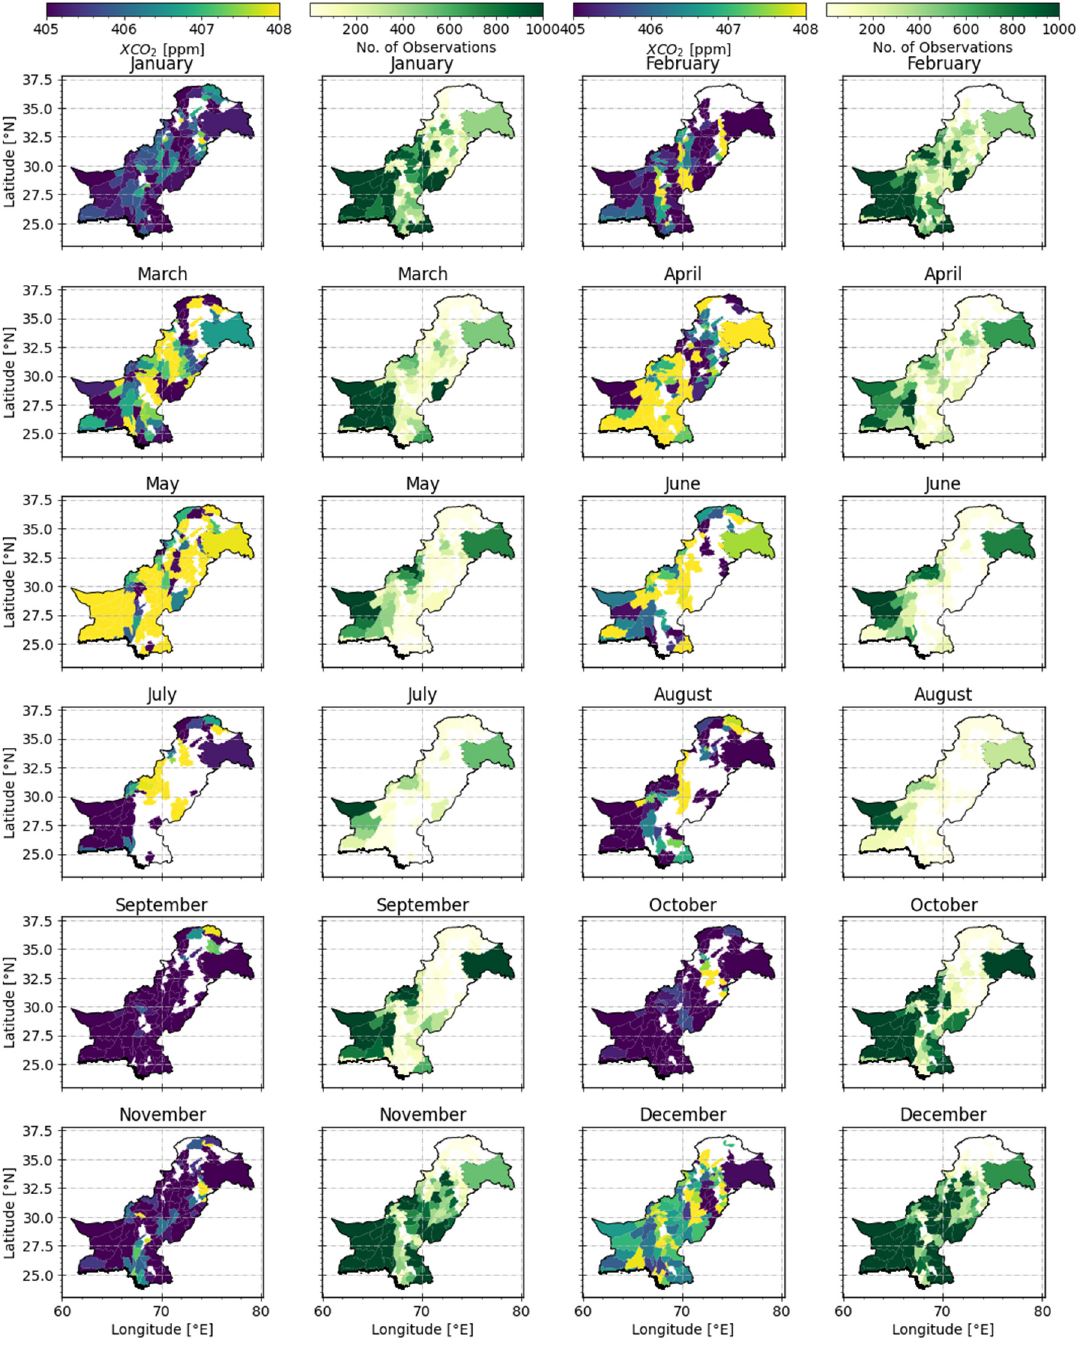
Figure 2. Spatial distribution of monthly averaged XCO 2 and the number of cloud-free OCO-2 retrievals in each district of Pakistan for a period of six years from January 2015 to December 2020.